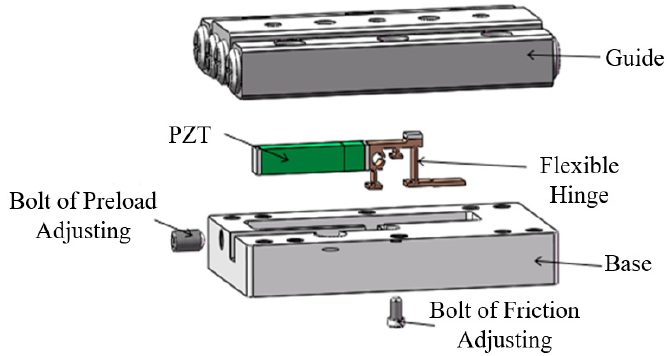
Figure 2. Structural model diagram of the proposed positioning stage.